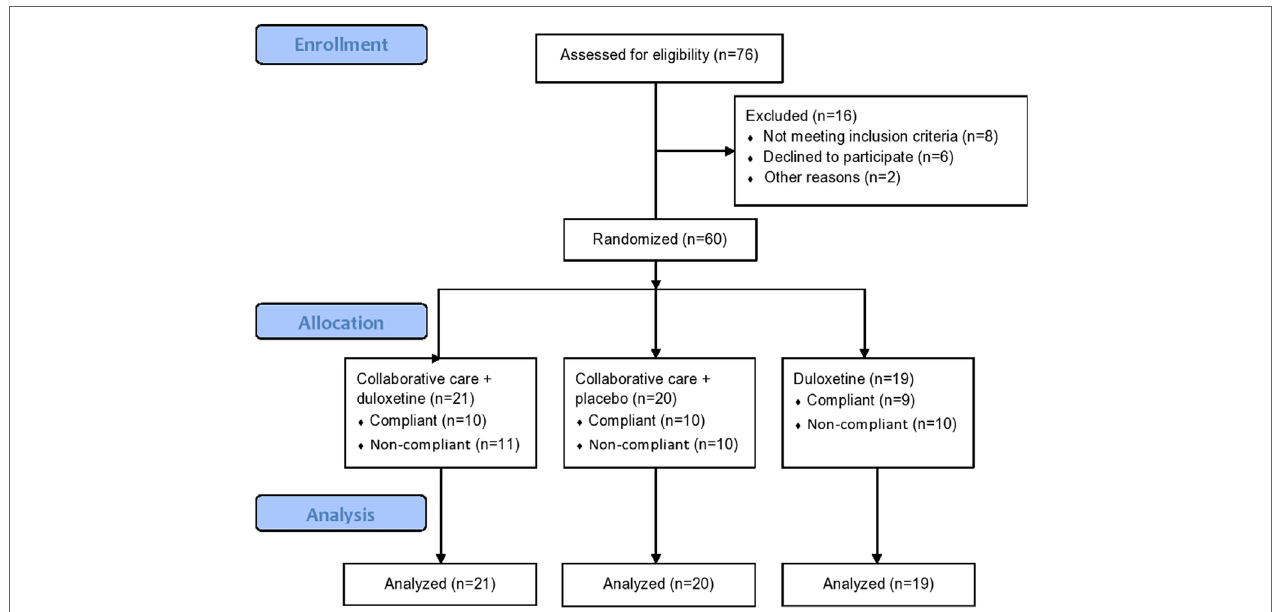
FigUrE 2 | Overview of inclusion, divided in three research groups and number of non-compliant (having missed three or more sessions) and compliant